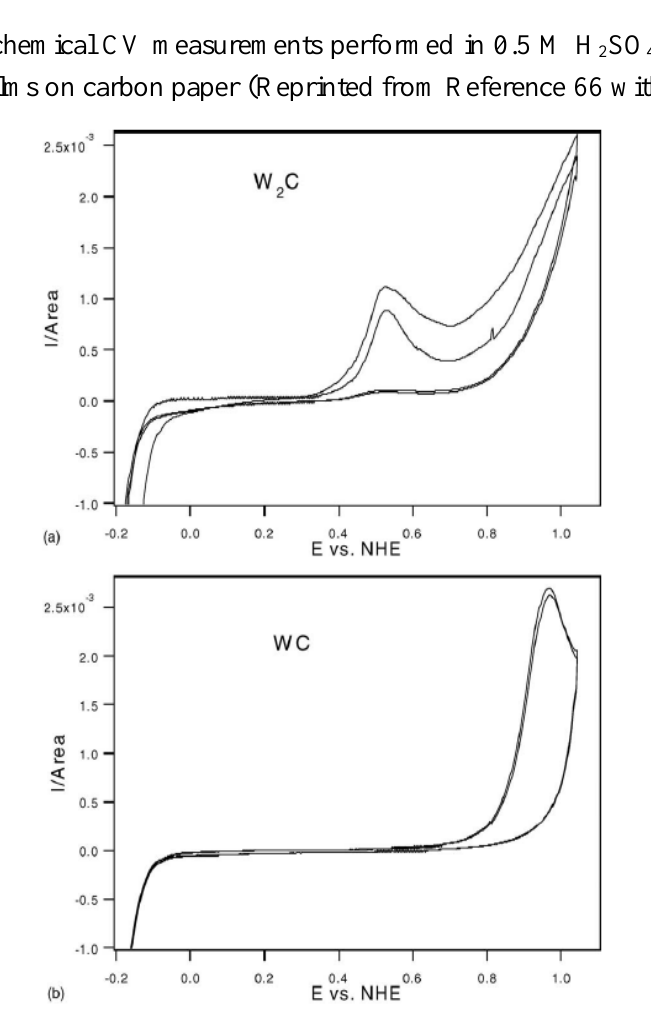
SO saturated with N 2 4 2